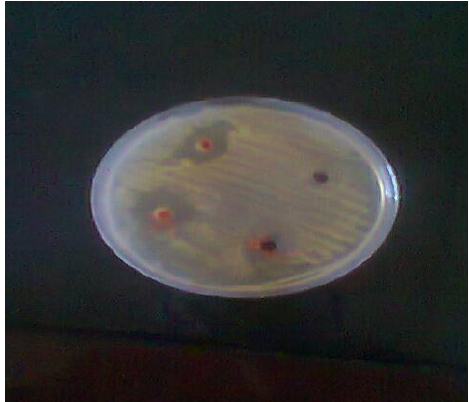
Figure (2): Inhibition zone for s taphylococcus epidermidis Discussion